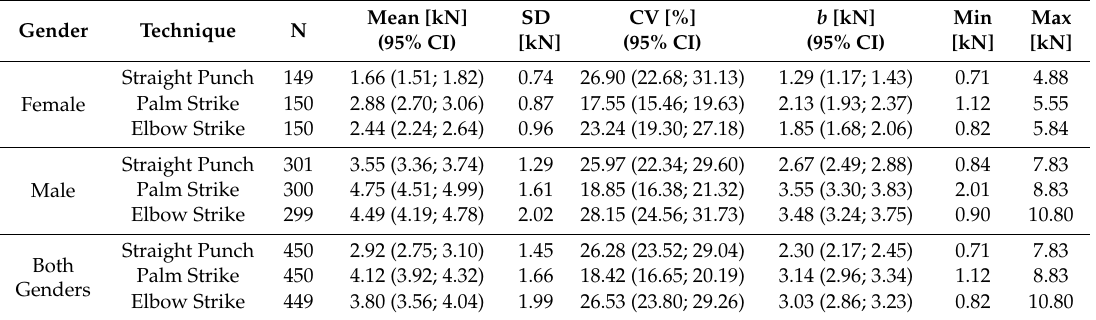
Table 2. Basic characteristics of strikes peak forces across the study subgroups (from all trials).